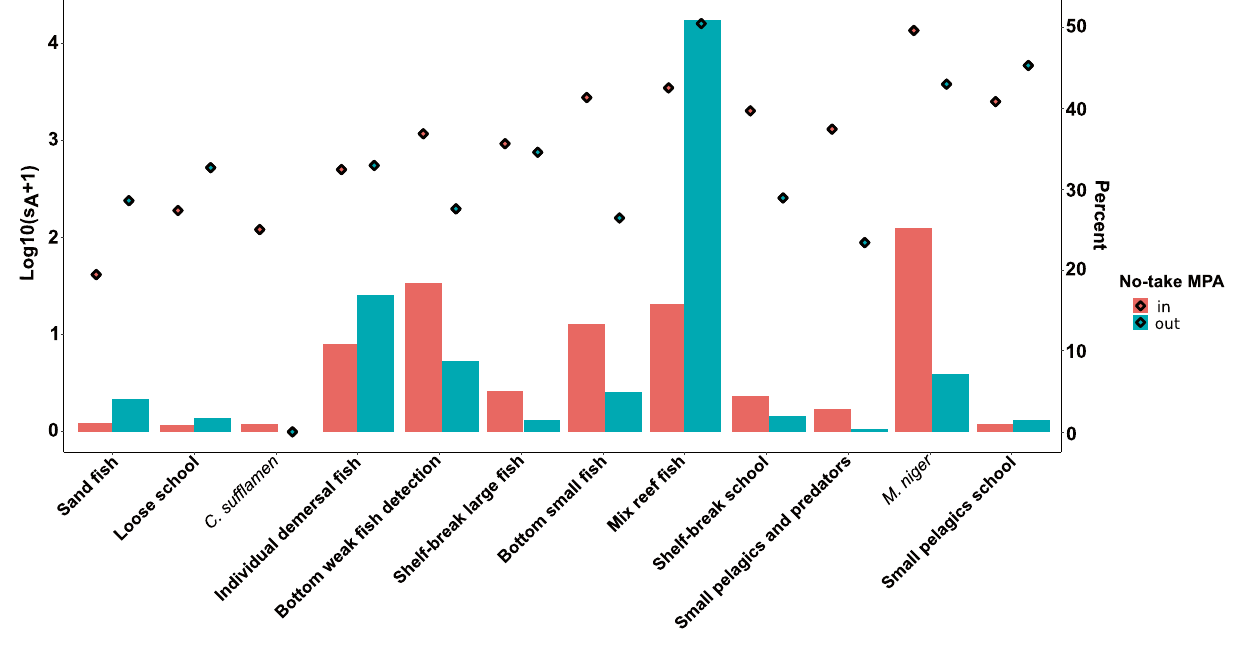
Figure 8. Barplot representing the percentage of ESDU with presence of each fish assemblage according to its position regarding the no-take zone and the mean acoustic biomass of each group (log10(s A + 1)) per ESDU (i.e. the total fish acoustic biomass normalised by the number of ESDU inside and outside the no-take zone) (diamonds).